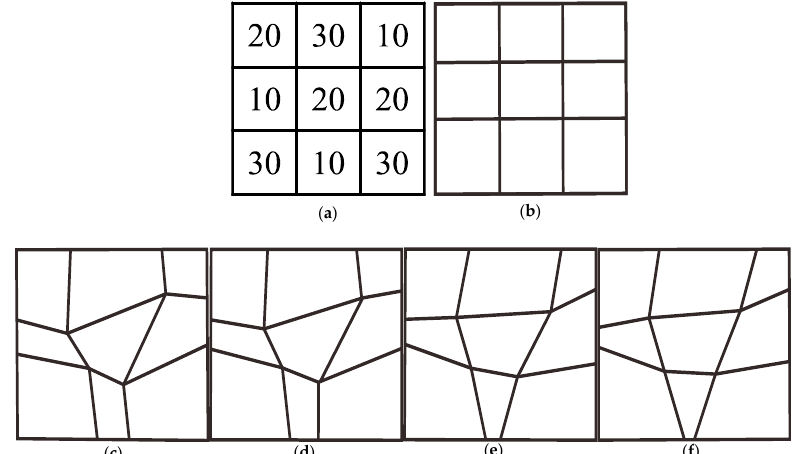
Figure 3. Quadrilateral table cartogram construction by different initial value of μ : ( a ) Original table; ( b ) Output of first step; ( c ) μ = 0.005; ( d ) μ = 0.01; ( e ) μ = 0.05; ( f ) μ = 0.1. Table 1 indicates the root mean square error (RMSE) between values and sizes of cells as the indices of data representation precision, the maximal and minimal inner angles, the RMSE of bearing angles of edges between table cartograms and original tables, and the RMSE between right angles and inner angles as indices of deformations. When the deformation is small, inner angles approach right angles, and the bearings angles of edges approach horizontal or vertical directions.